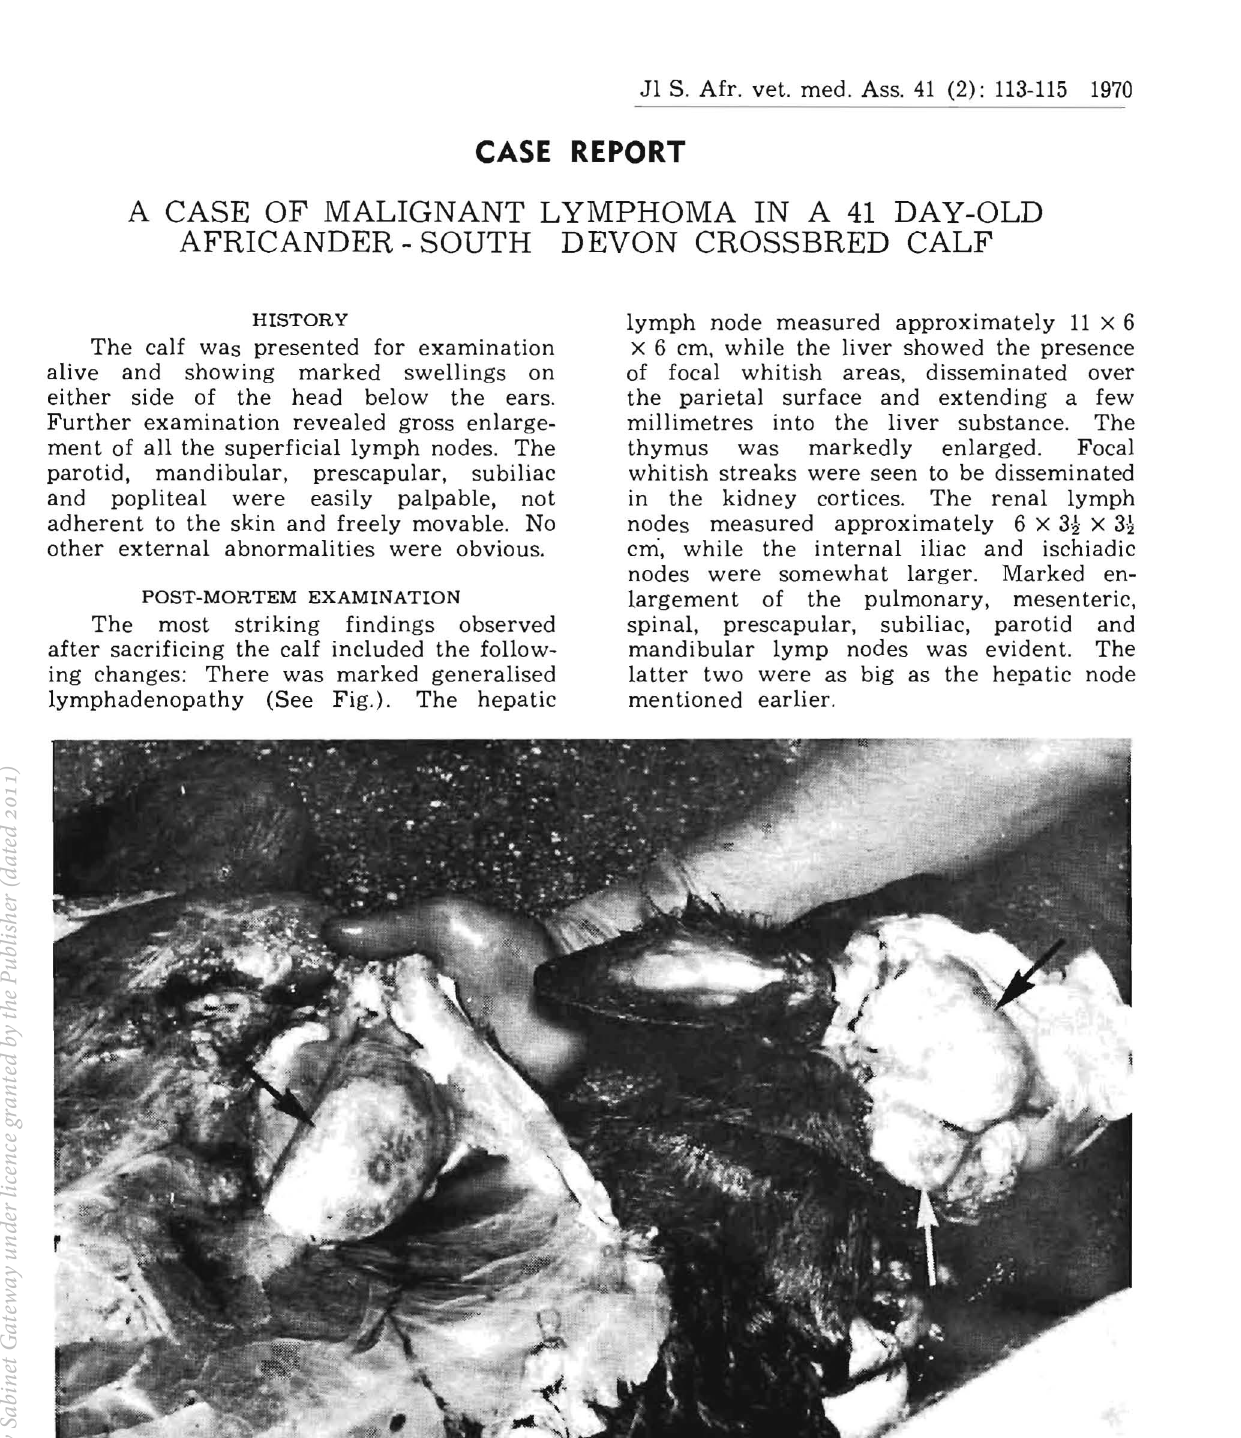
FIG. Enlargement of prescapular. parotid and mandi bular lympb nodes